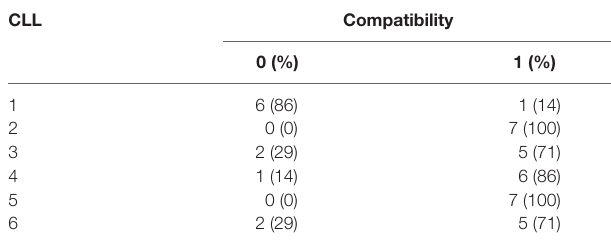
TaBle 3 | Distribution of matched (0)/mismatched (1) combinations for each cll patient.